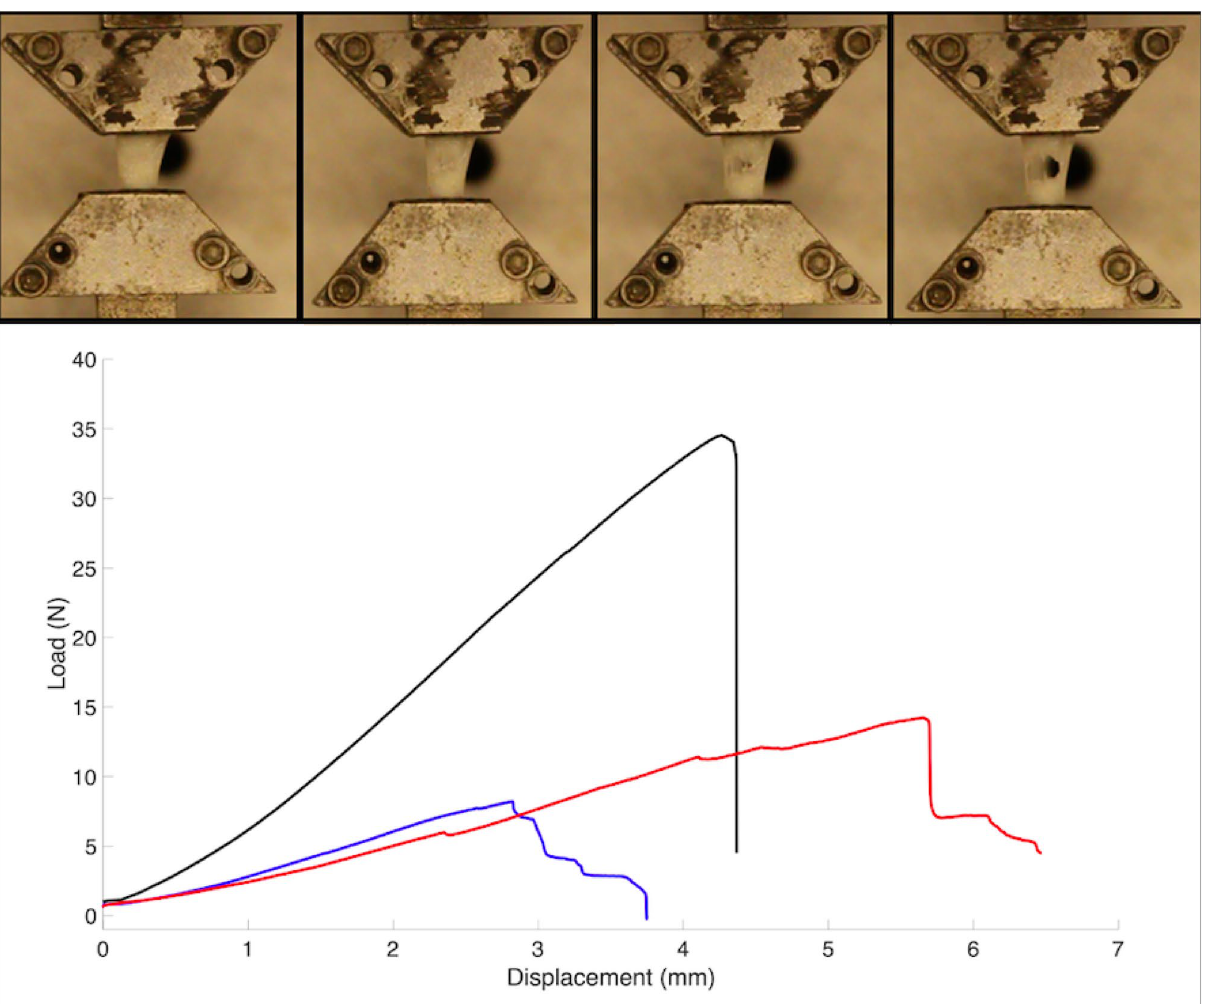
Figure 3. Biomechanical apparatus demonstrating the progression of tissue failure (top). Biomechanical testing of 3 different healing states (bottom): non-healed (blue), healed (red), and control